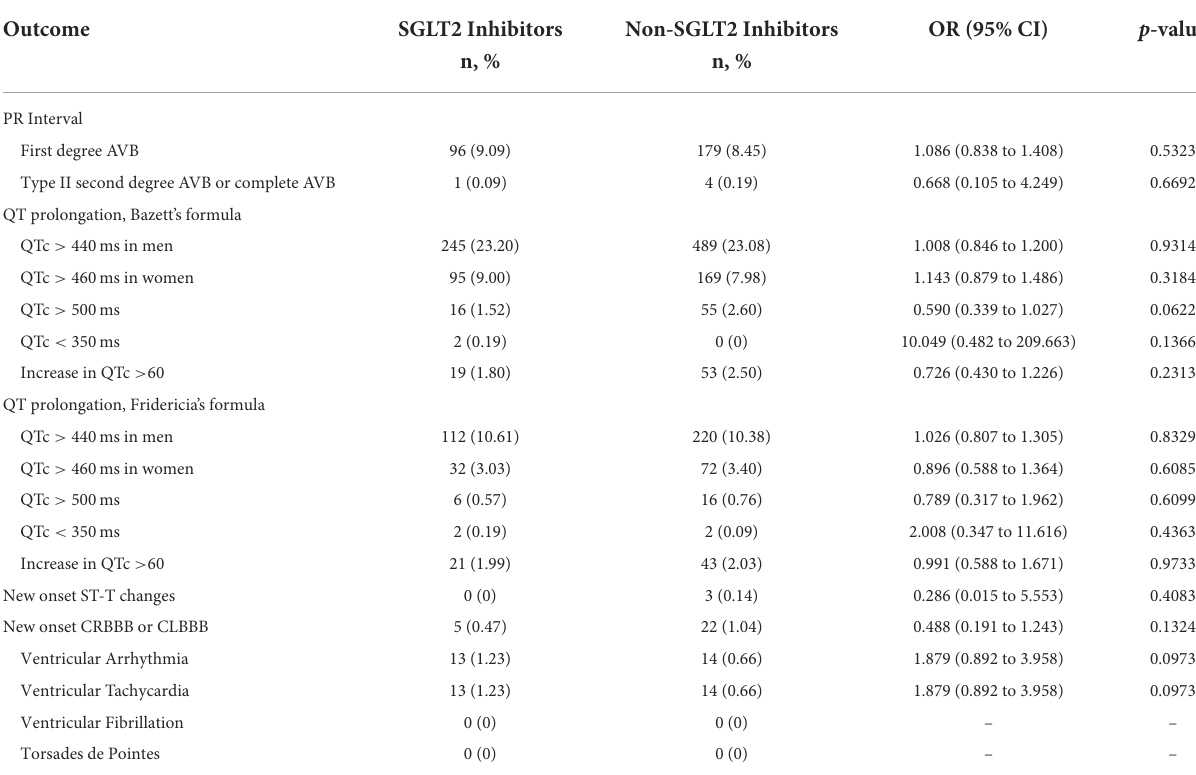
TABLE 3 ECG outcomes of study